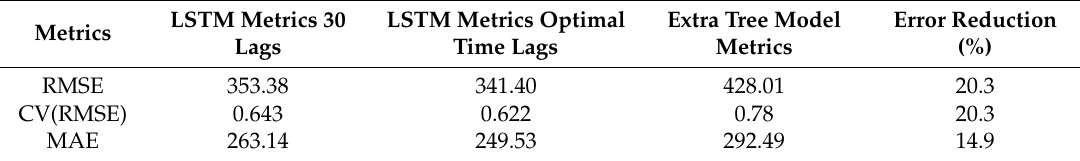
Table 4. Performance metrics of the long short-term memory (LSTM) Model on the test set.